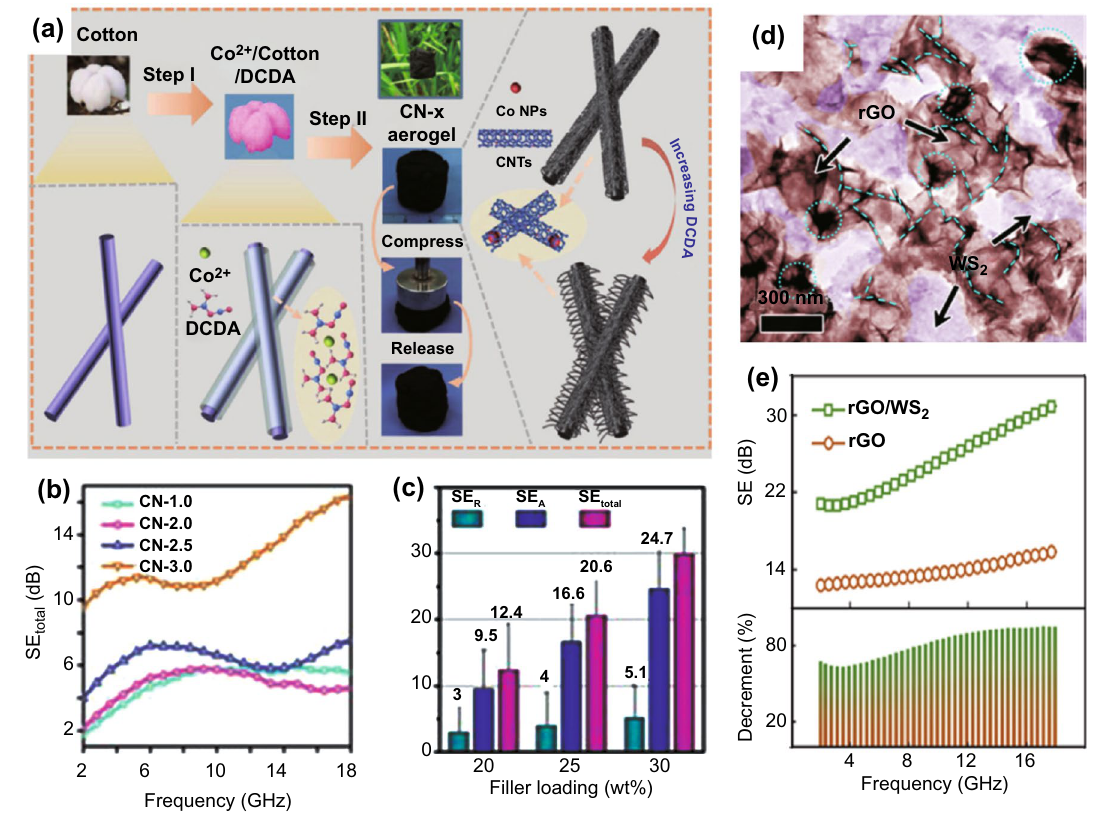
Fig. 9 a Schematic graph of the formation process of CN-x composites. b The SE T of all composites. c Shielding effective of SE R , SE A and SE T values of CN-3.0 composite with different filler loadings of 20, 25 and 30 wt% [74]. Copyright © 2019 WILEY ‐ VCH Verlag GmbH & Co. KGaA, Weinheim. d TEM images of WS 2 − rGO architecture. e SE of WS2 − rGO at and comparison with rGO [37]. Copyright © 2019 ACS